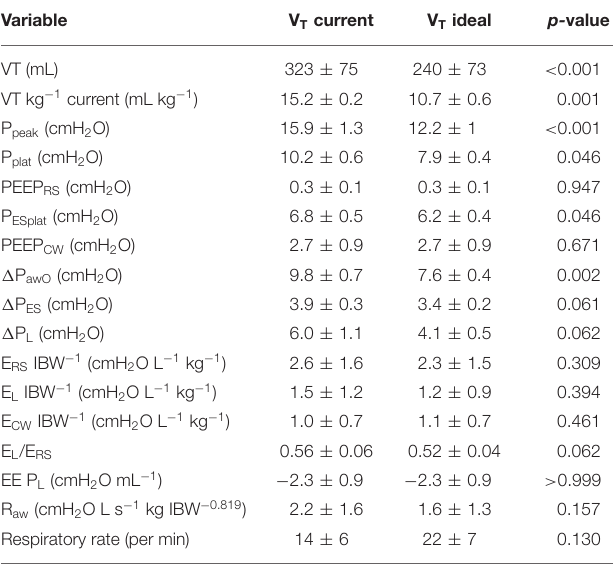
TABLE 2 | Global and partitioned respiratory system mechanics in a group of six obese anesthetized dogs undergoing computed tomography scans, and ventilated with tidal volumes based on current vs. ideal body weight.